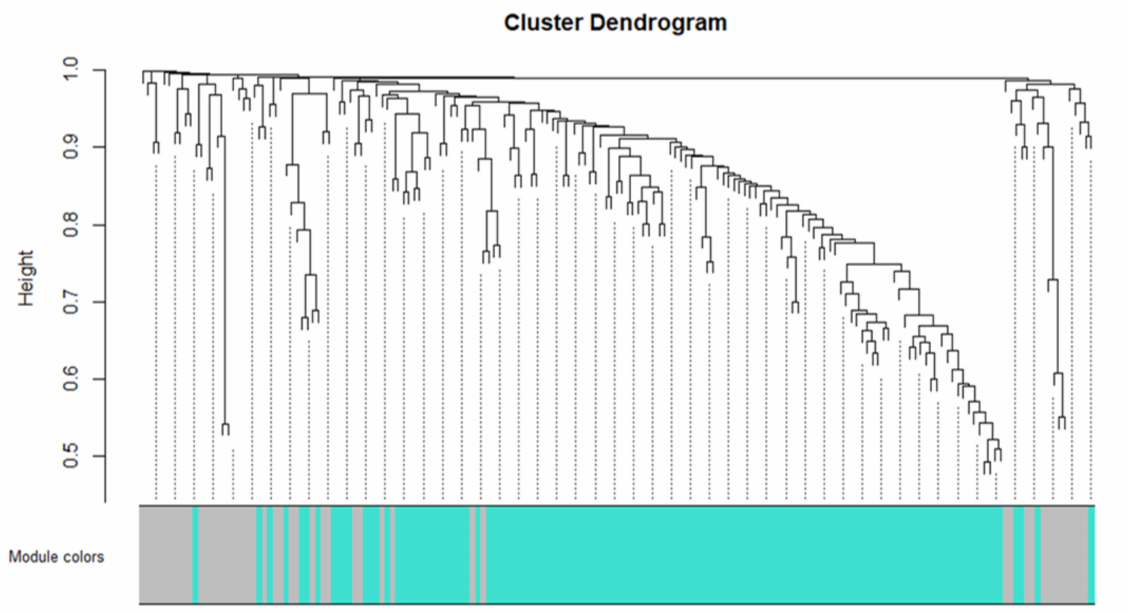
Figure 3. Hierarchical cluster dendrogram and gene module identified by weighted correlation network analysis (WGCNA). Gray genes are not included in any module.